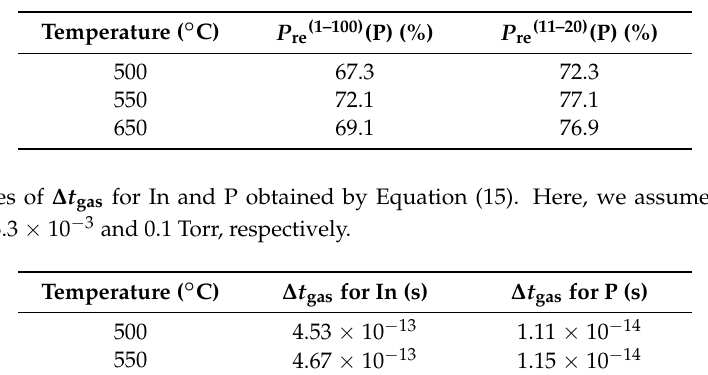
Table 1. Relative adsorption probabilities of a P atom on the In-adsorbed ( 1100 ) and ( 1120 ) surfaces, P re(1–100) (P) and P re(11–20) (P), respectively, obtained by MC simulations. It should be noted that P re(1–100) (In) + P re(1–100) (P) = P re(11–20) (In) + P re(11–20) (P) = 100%, where P re(1–100) (In) and P re(11–20) (In) are relative adsorption probabilities of an In atom on the In-adsorbed surfaces. Here, we assume that pressure is 0.1 Torr.